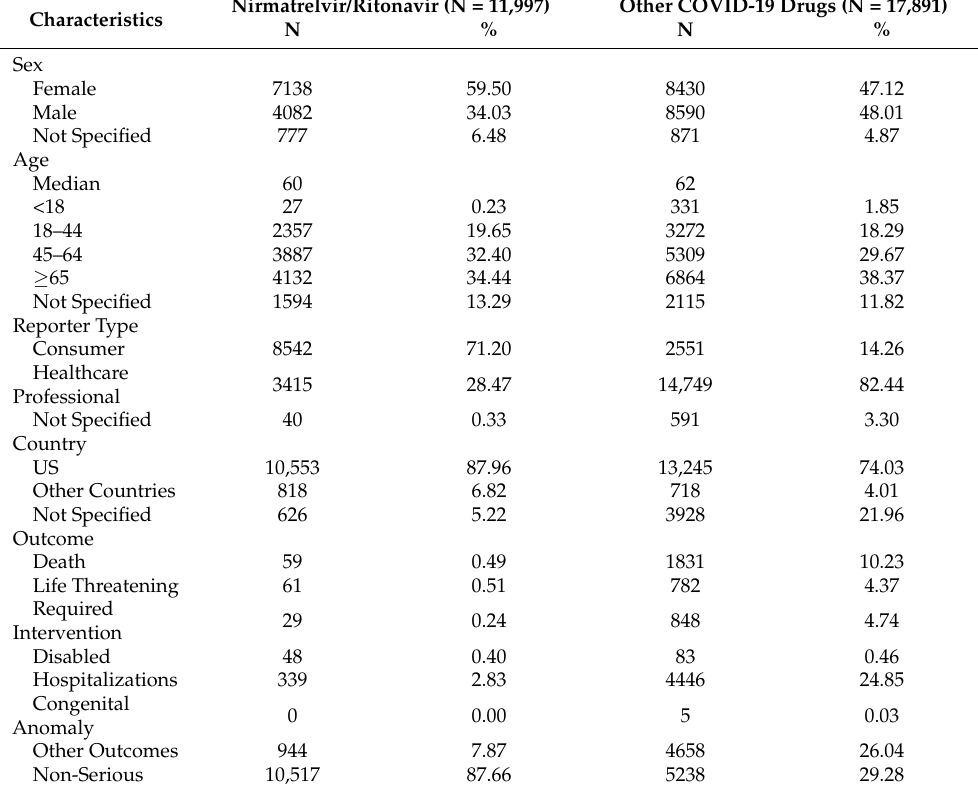
Table 2. Characteristics of adverse event reports using nirmatrelvir/ritonavir or other COVID-19 drugs as suspected